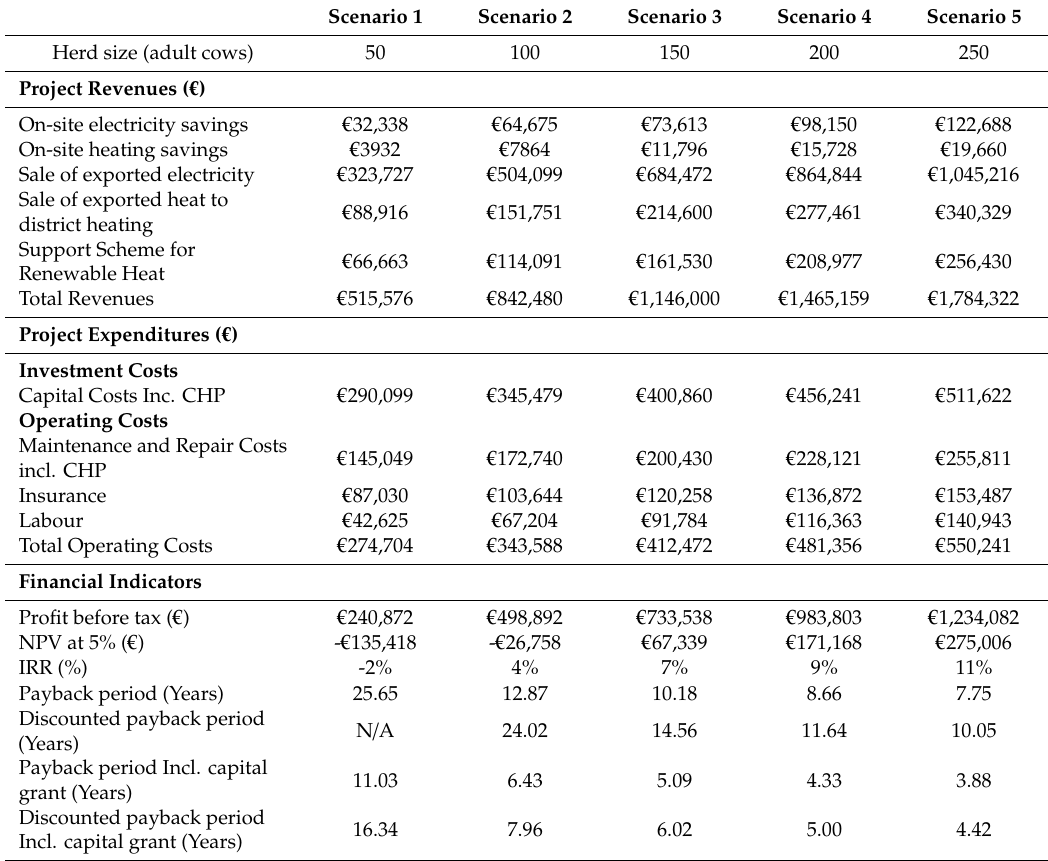
Table 7. Economic results of small-scale anaerobic digestion plants over a 20-year